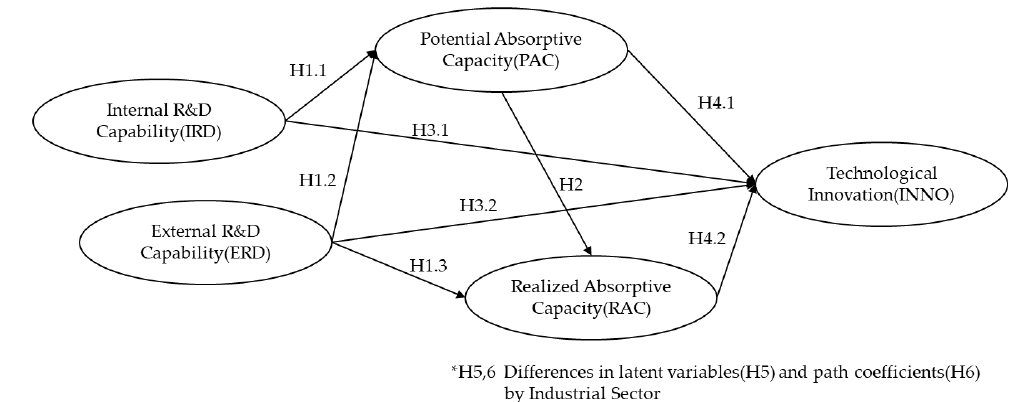
Figure 2. Research Figure 2. Research model.